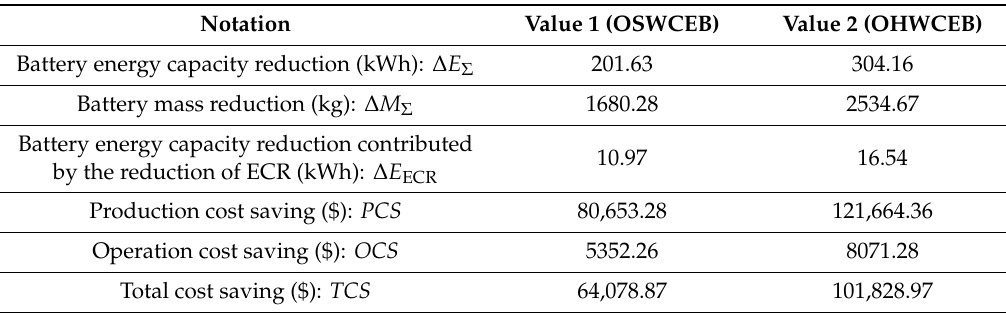
Table 3. The results of the numerical